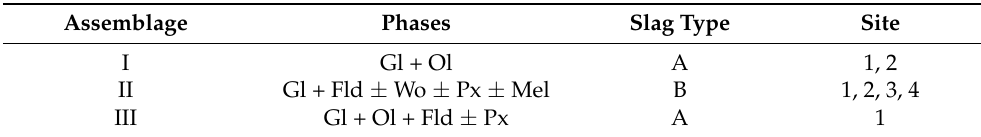
Table 2. Phase assemblages identified in studied slags by combination of optical microscopy, electron microprobe, and XRD.